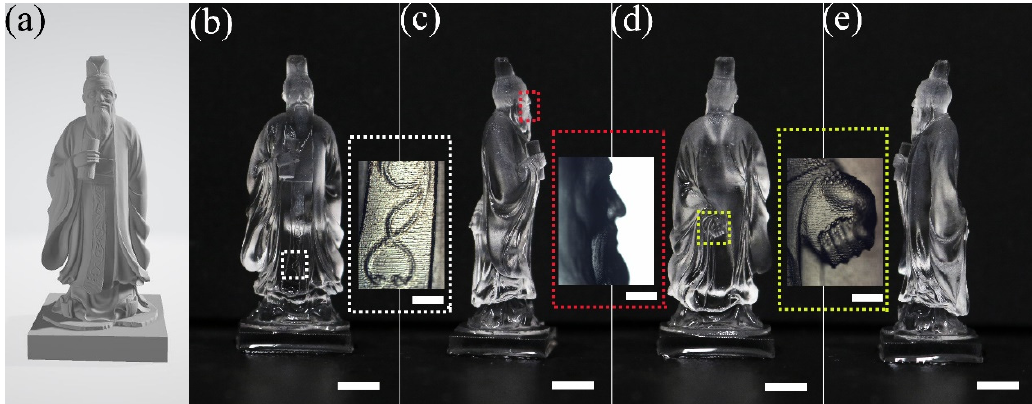
Figure 5. A laser printed sculpture of Confucius in fused silica. ( a ) The model and the ( b ) front, ( c ) left, ( d ) back, and ( e ) right sides of the sculpture. The details of the decorative pattern on the cloth, the right side of his face, and the left hand hanging behind his body are shown in the insets on the right-hand side of the images in (b), (c) and (d), respectively. Scale bar at the bottom: 5 mm. Scale bar in insets: 1 mm.